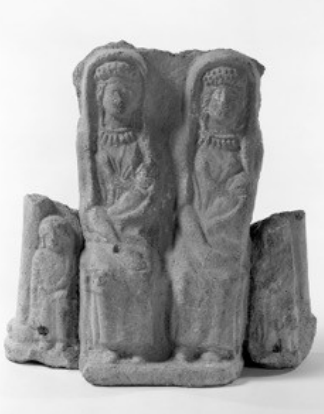
Figure 8. Caere. From Nagy, “Votive”, 234f., Fig.